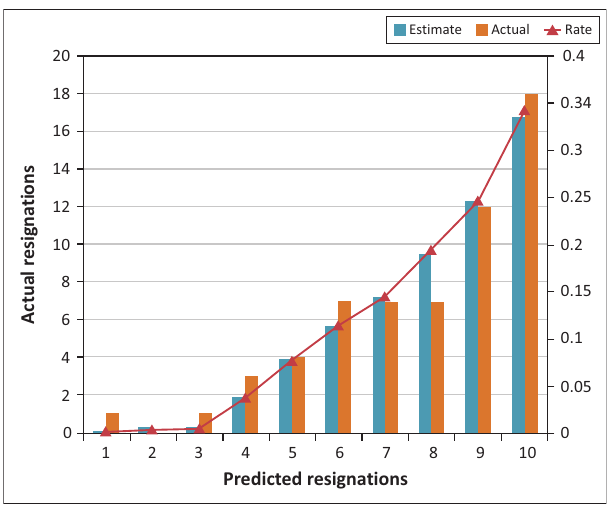
FIGURE 1: Comparison of actual and predicted resignations using the test